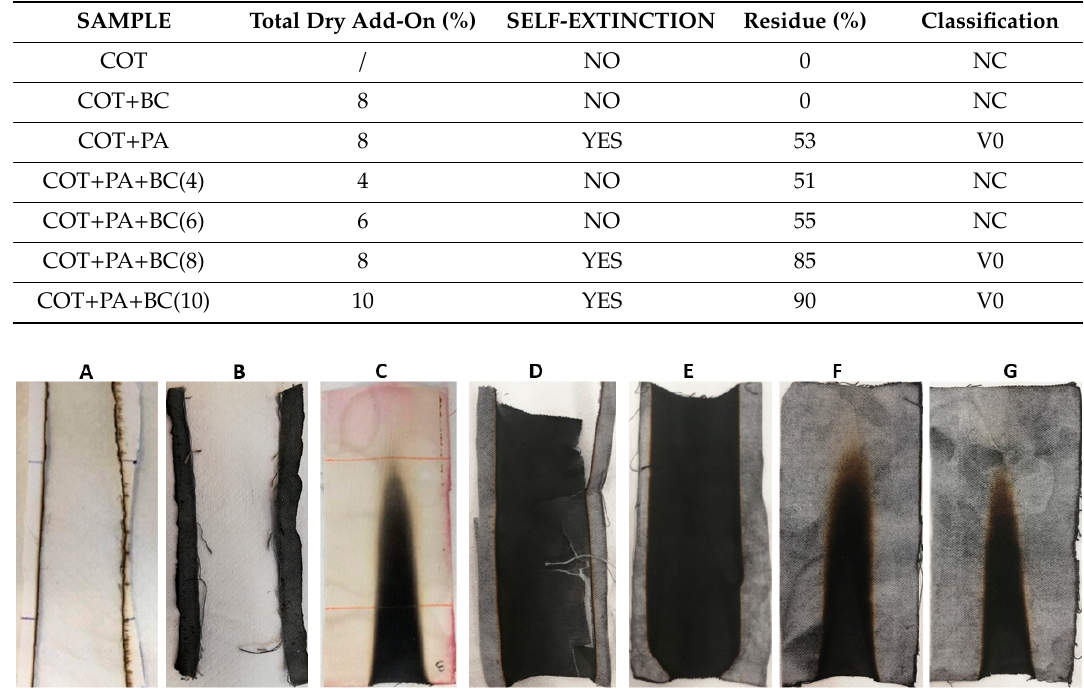
Table 2. Results of vertical flame spread tests performed on cotton and on the treated fabrics. SAMPLE